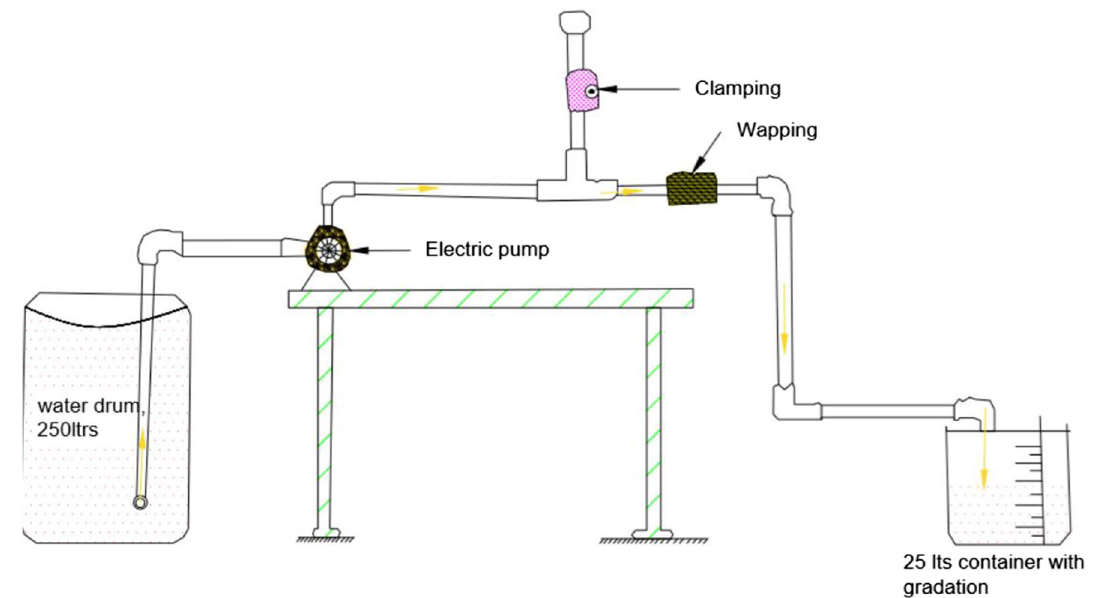
Fig. 3 Network diagram of experimental setup